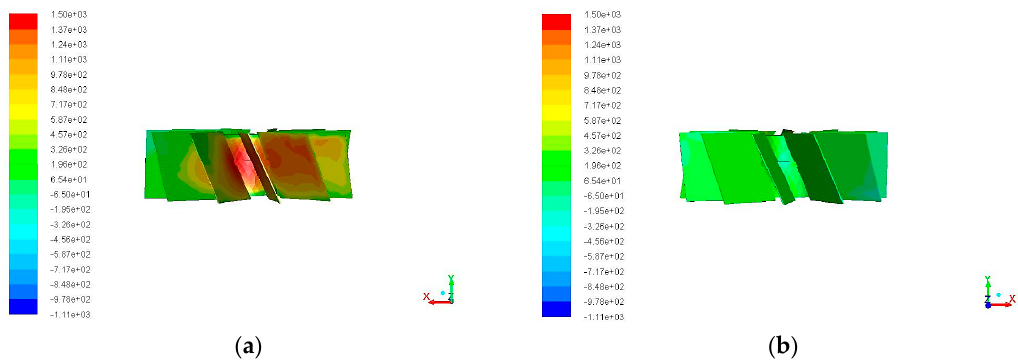
Figure 13. Static pressure (Pa) distribution ( a ) on the contested surface; ( b ) on the non-contested surface of one-stage KIONAS, rotor blade angle of 25 degrees and stator with flat guide vanes.